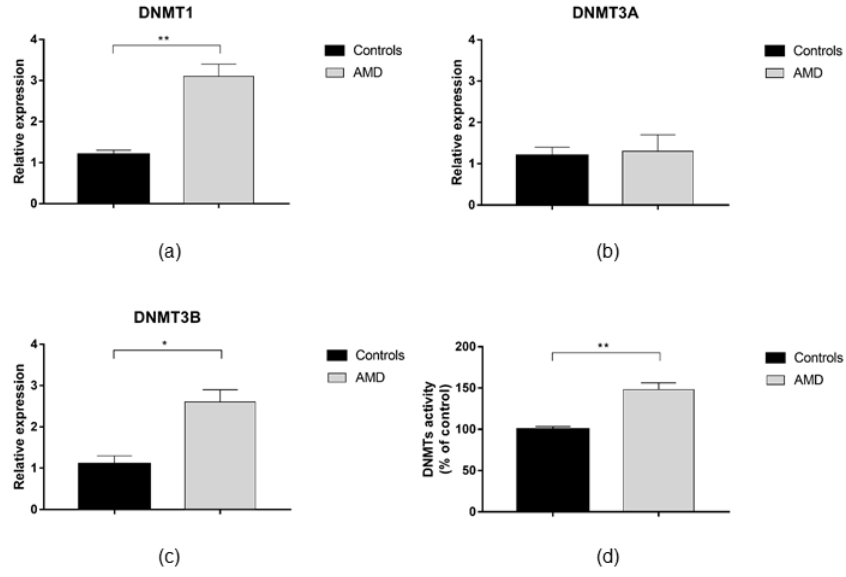
Figure 1. DNA methyltransferases (DNMTs) expression and activity in age-related macular degeneration (AMD) patients and age- and sex-matched controls. The analysis of gene expression showed that: ( a ) DNMT1 ( p = 0.003) and ( c ) DNMT3b ( p = 0.018) were up-regulated in AMD patients ( n = 40) compared with controls ( n = 10). ( b ) No difference was observed in DNMT3a expression. ( d ) The analysis of total DNMTs activity showed higher levels in AMD patients than in controls (48%; p = 0.005). Bar graphs show mean ± SE. * p < 0.05, ** p < 0.01 versus controls based on the Student's t -test. DNMT, DNA methyltransferases; AMD, age-related macular degeneration; SE, standard error.